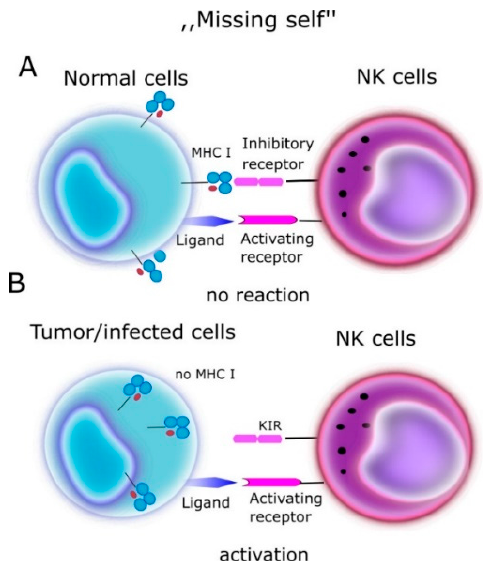
Figure 1. “Missing self” hypothesis according to NK cells kill cells with weak or no MHC-I expression. MHC molecules play a protective role against normal host cells, protecting them against lysis through NK cells. ( A ) On a normal cell there are MHC antigens (ligands for KIR)—no reaction. ( B ) On tumor/infected cells no MHC- NK cells